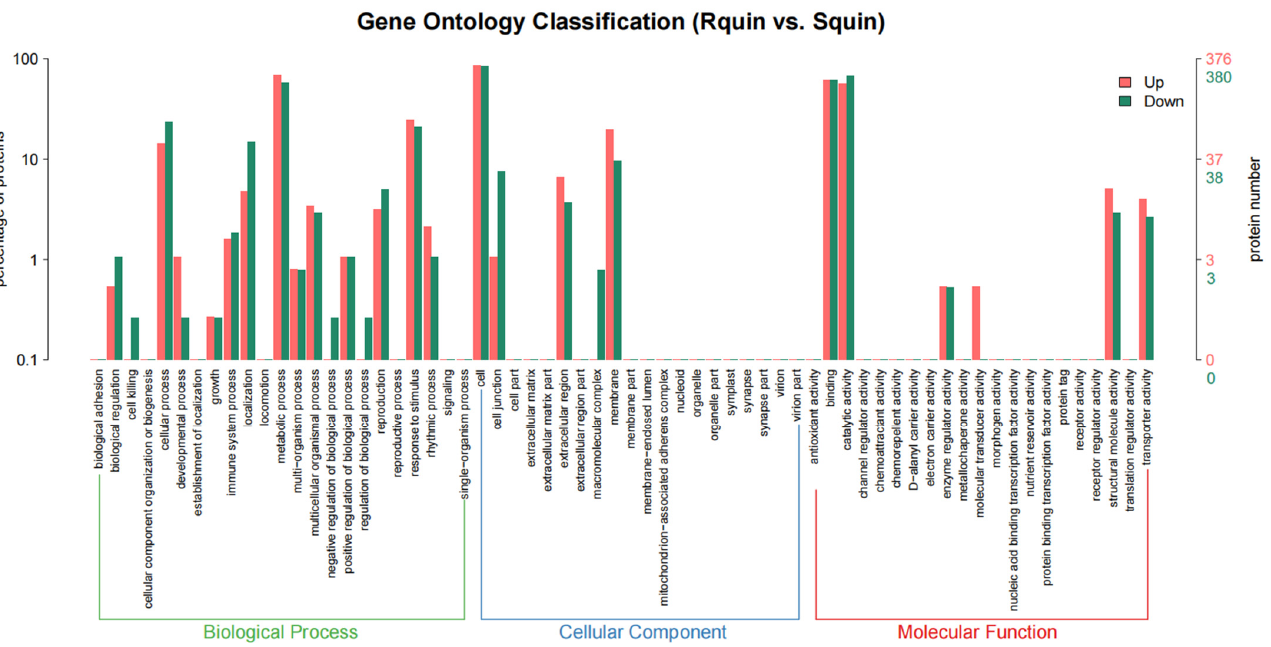
Figure 9. A GO enrichment analysis map of differentially accumulated protein species between quinclorac-resistant and -sensitive E. crus-galli with quinclorac treatment (Rquin vs. Squin). Table 2. The major differentially accumulated proteins between quinclorac-resistant (Rquin) and -sensitive (Squin) E. crus-galli with quinclorac